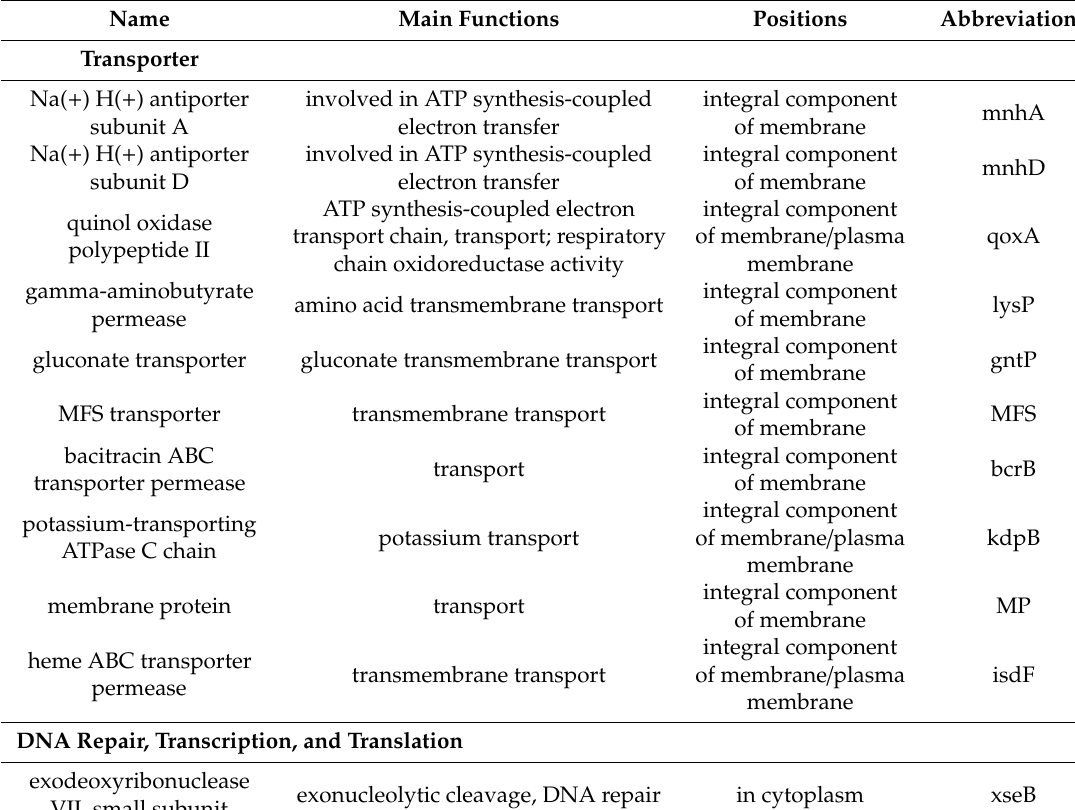
Table 2. The positions, functions, and abbreviations of functional